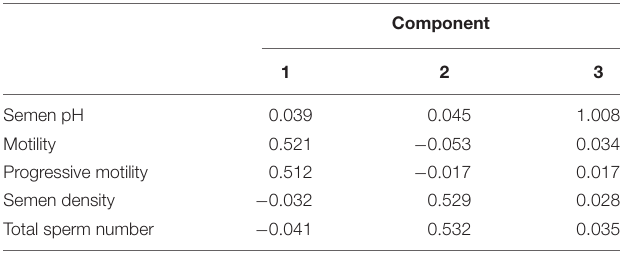
TABLE 3 | Component score coefficient matrix.